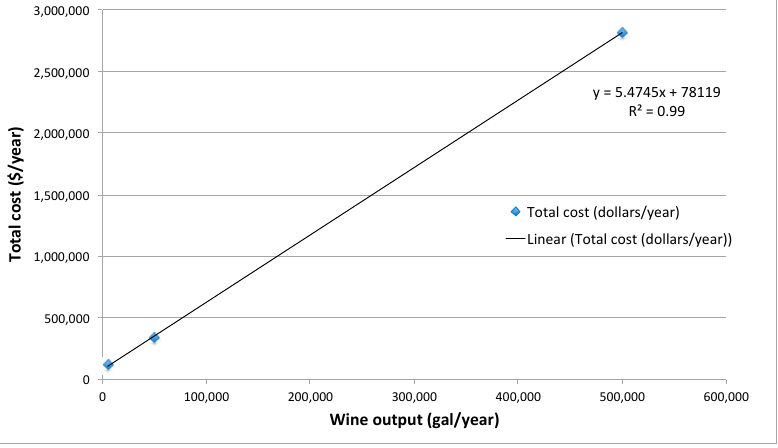
Figure 5. Annual production costs according to scale of operation (showing linear trendline).